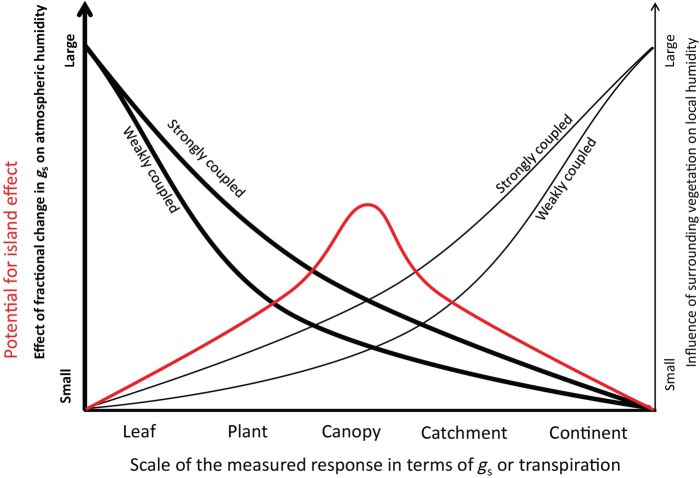
The potential for the island effect is maximal at intermediate spatial scales. This is because the two effects shown (effect of gs on atmospheric humidity, influence of surrounding vegetation on local humidity) are compensatory in terms of promoting the island effect. Generally, atmospherically well-coupled plants/stands such as tree canopies are more prone to the island effect than less coupled ones (e.g. grassland, see McNaughton and Jarvis 1991).